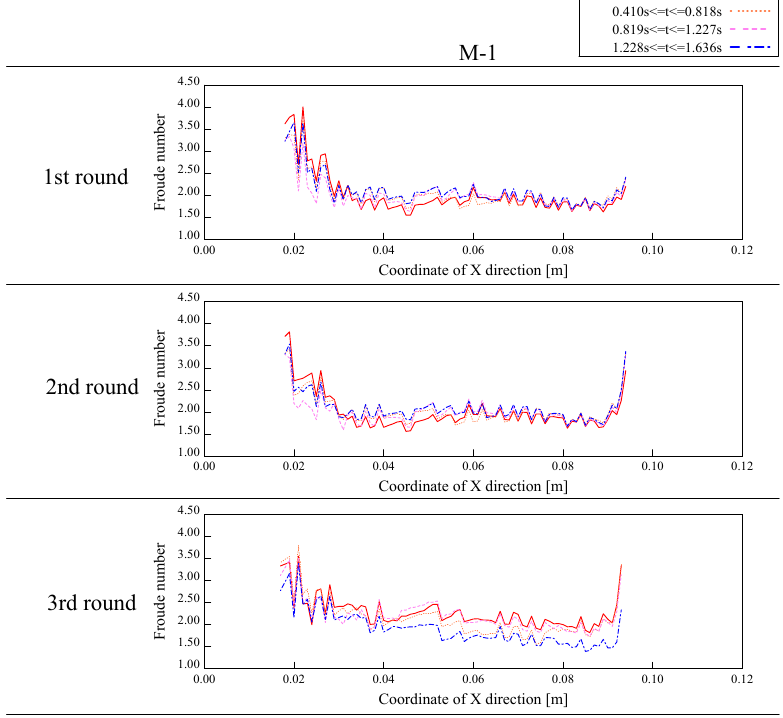
Figure 15. Relationship of Reynolds numbers in each cross section. 5. Inverse Simulation Using the Experimental Results 5.1. Conditions of Numerical Analysis In this simulation, a two-dimensional numerical model was used, based on the results of experiments using a rotary drum device. Figure 16 shows the numerical model used in the simulation. The snow density was based on the results of the experiments and were set at 363 (1 mm), 335 (2 mm), and 308 (4 mm) kg/m 3 . The airflow was also incorporated, and the air density and viscosity coefficient were set at 1.25 kg/m 3 and 2.00 × 10 − 5 Pa·s, respectively. Table 3 shows the input parameters of the snow. A uniform cartesian mesh was applied in the simulation, using a 1 mm mesh size ( Δ x = Δ y = 1 mm). The calculation domain was inclined to minimize the calculation costs, and the incline of the model slope was specified in the form of a horizontal component of gravity (35 degrees counterclockwise). In this study, we performed two-dimensional inverse simulation using the flow velocity data of the artificial flow, obtained from the rotating drum test. The flow velocity data targeted an area